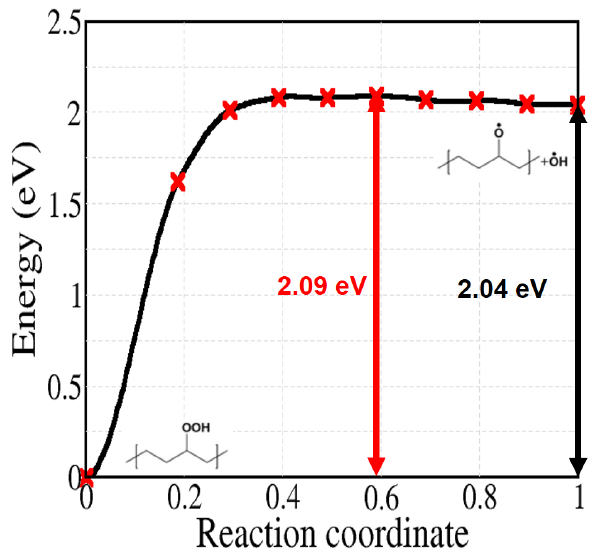
Figure 8. Calculated energy profile for reaction 5 of Figure 2.